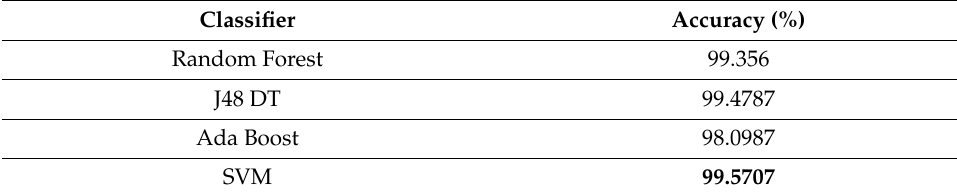
Table 14. Comparative results for the classifiers.